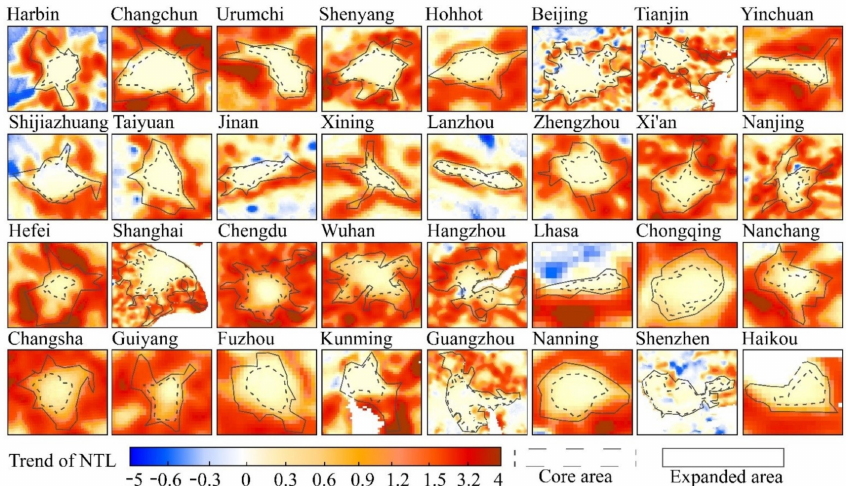
Figure 7. Spatial distribution of NTL trends in 32 major cities in China from 2001 to 2018, with dotted lines representing the boundaries of core areas and solid lines representing the boundaries of extended